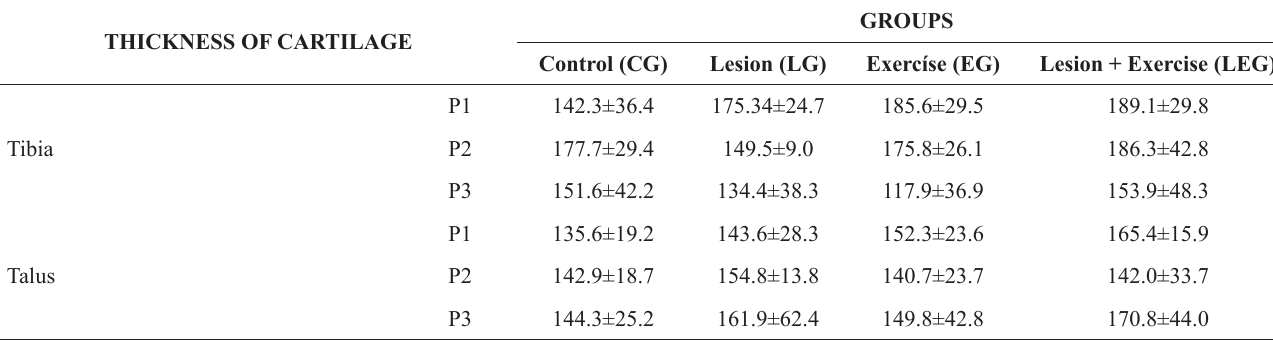
Table 1. Thickness of articular cartilage (μm) of the tibia and talus.